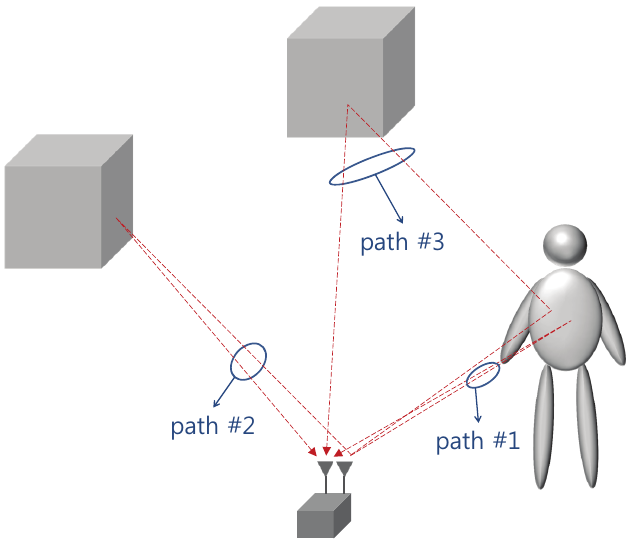
Figure 1. Different reflection scenarios caused by a moving